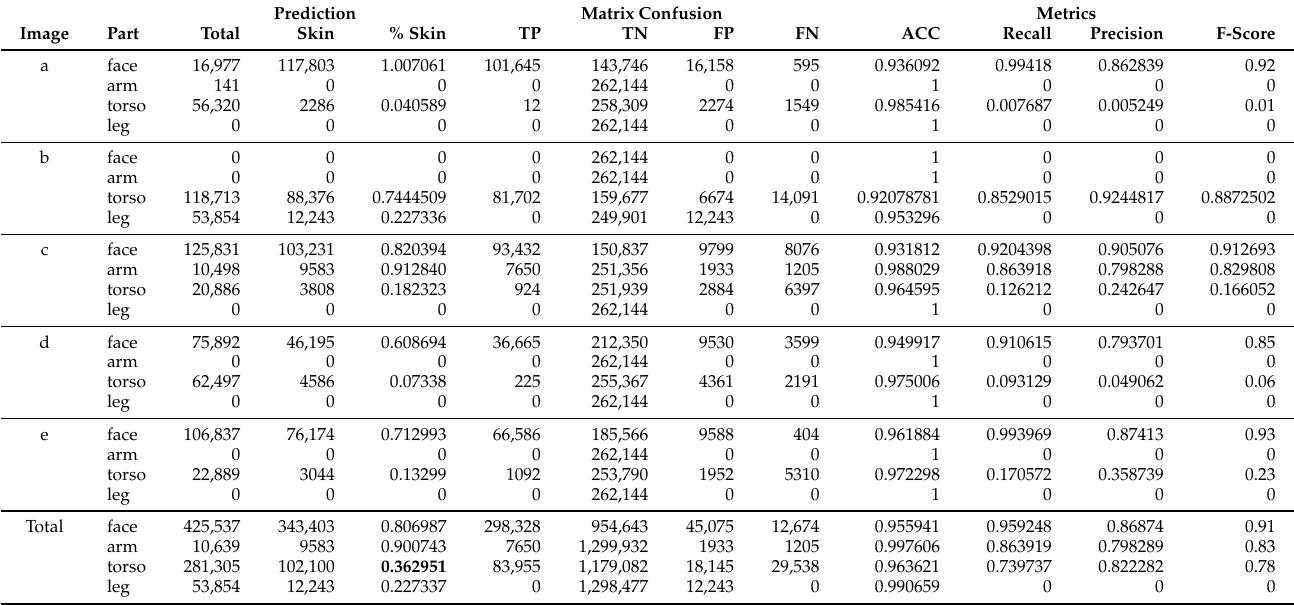
Table 5. Results obtained from the experiment performed, segmented by part. Prediction